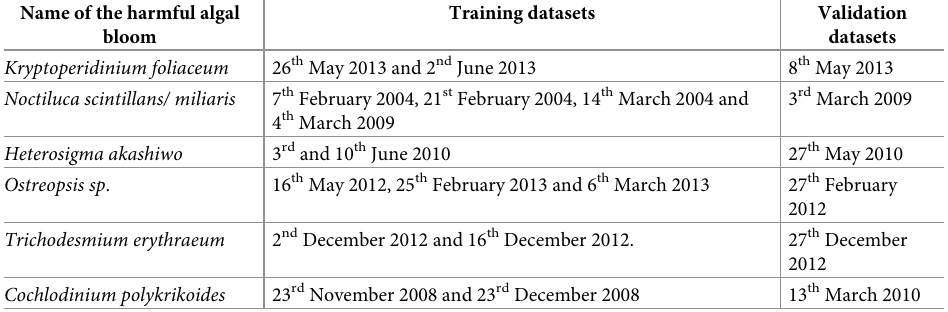
Table 1. Summary of the satellite datasets for the different types of harmful algal blooms (HABs) in the Red Sea. Name of the harmful algal